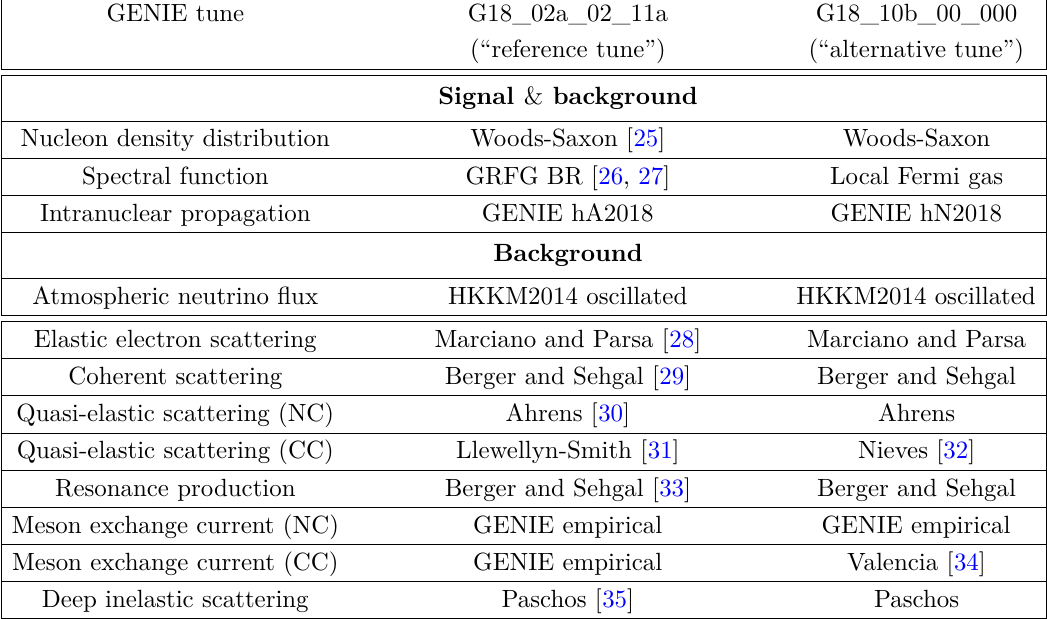
Table 1 . List of event generator models for the two GENIE tunes used in the proton decay sensitiv- ity study. The abbreviation GRFG BR stands for global relativistic Fermi gas with Bodek-Ritchie extension, and CC and NC indicate charged current and neutral current neutrino